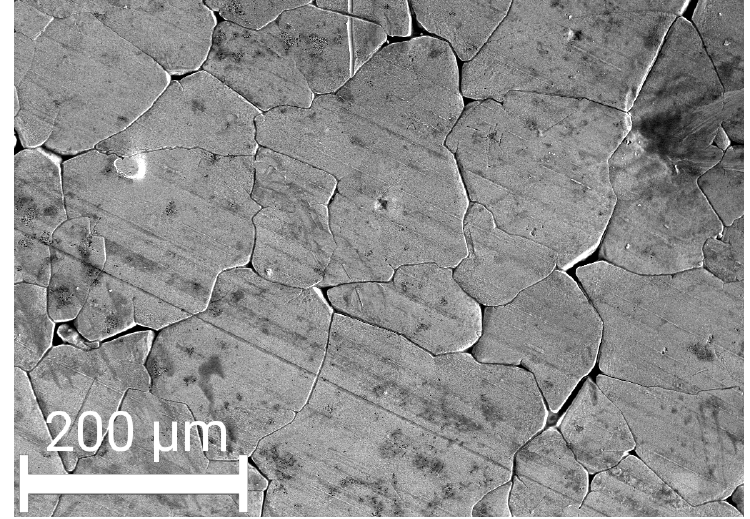
Figure 8. Secondary electron image in SEM for sample SAA1000. The cracks were formed at the grain